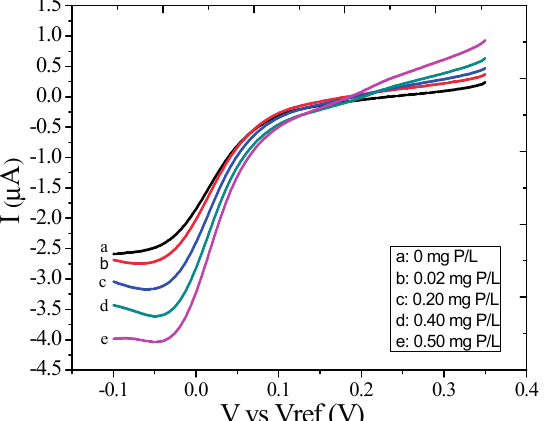
Figure 5. LSV responses of different concentrations of phosphate.